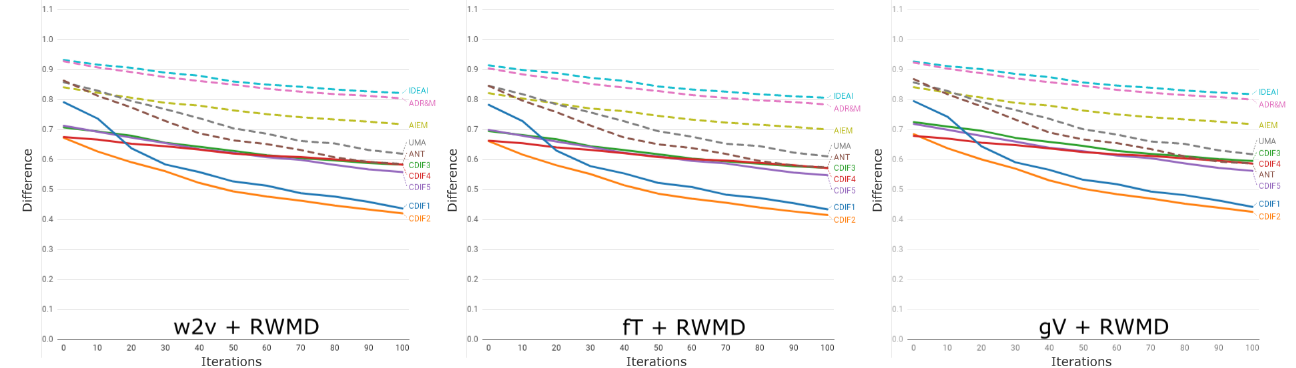
Figure 4. Analysis of RWMD with three different embeddings: w2v ( left ), fT ( center ), and gV ( right ). Distances decrease, and in two cases (w2v and fT), the papers of the CDIF group are also closer to the base paper, as expected.